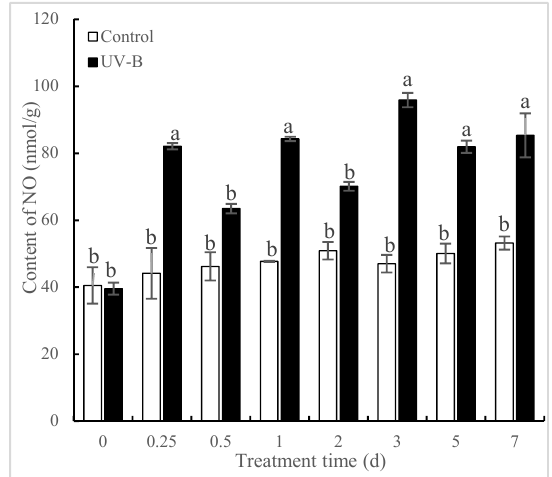
Figure 2. Effects of UV-B irradiation on NO content of P. quinquefolius roots. The P. quinquefolius roots that were irradiated with 4 kJ/m 2 UV-B for 5 h were taken for measuring nitric oxide (NO) and jasmonic acid (JA) contents during a 21-day postharvest drying process. Data are means ± SE of three replicates. Different letters indicate significantly different values according to one-way ANOVA followed by Student–Newman–Keuls tests ( p < 0.05).